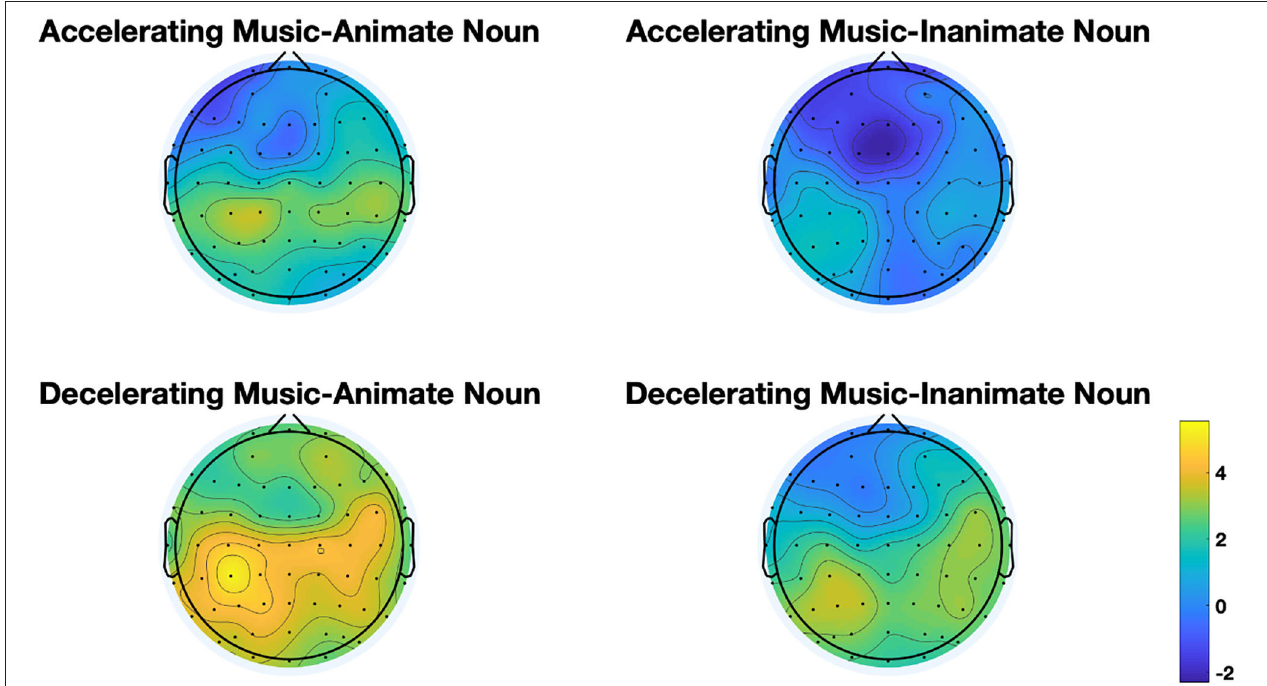
FIGURE 8 | Scalp topographic maps of N400 across the four conditions in Task